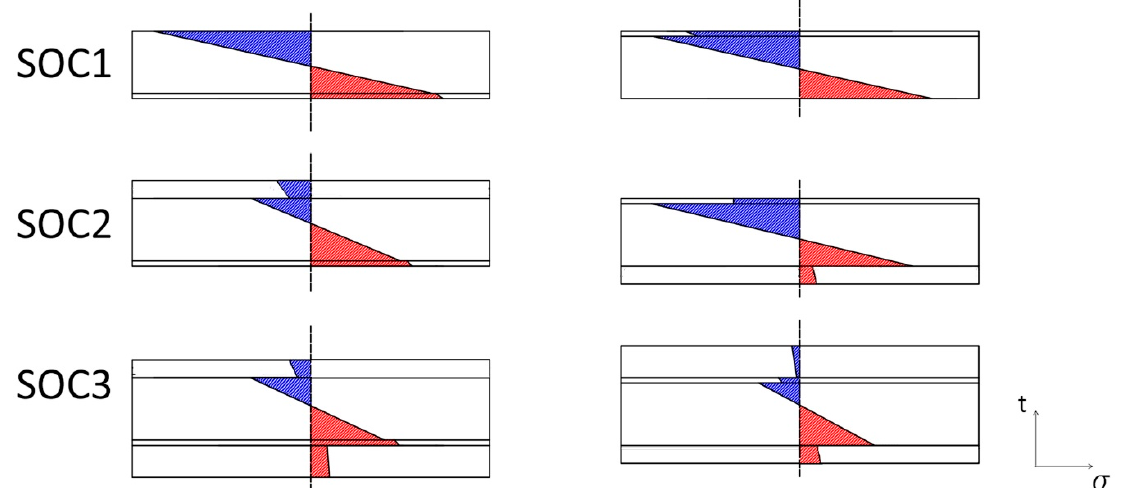
Figure 12. Stress distribution across the section of the layered samples tested in biaxial flexure. Compressive stresses are indicated in blue, tensile stresses in red.